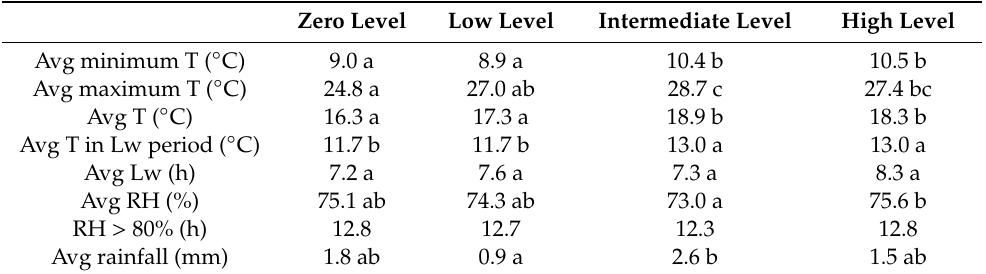
Table 5. Descriptive analysis of meteorological factors according to Alternaria conidia classes